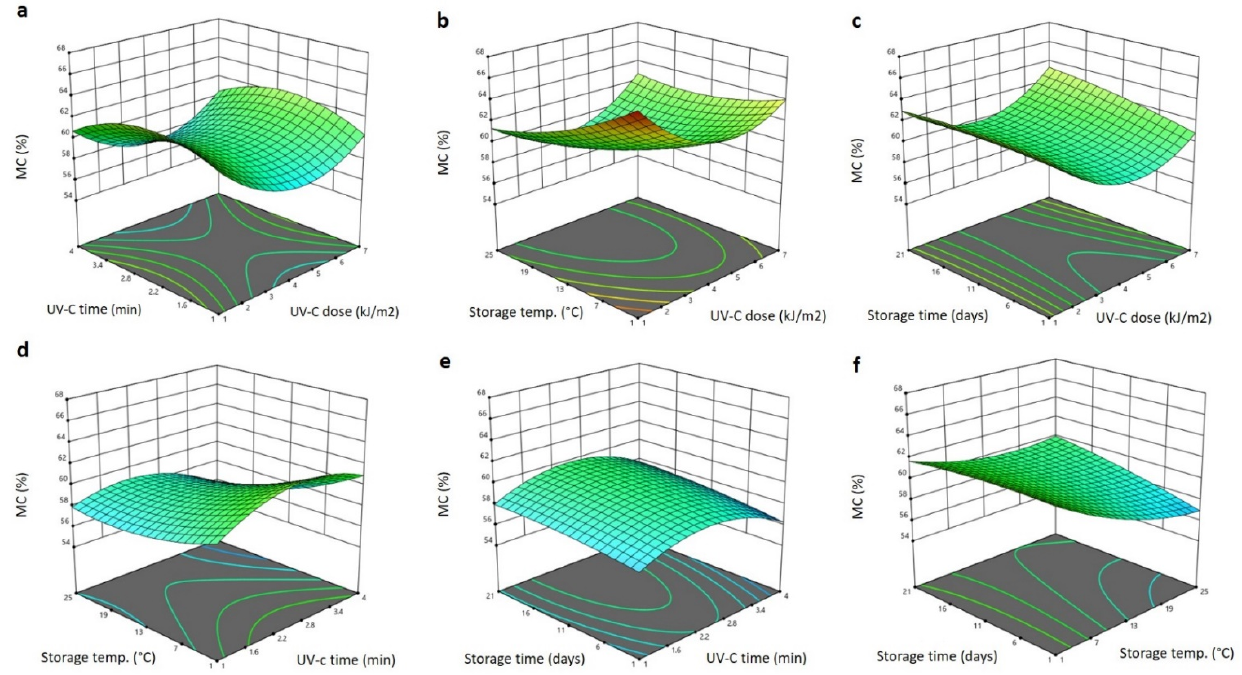
Figure 2. Response surface plots of moisture content (MC) of Barhi dates as a function of UV-C time and UV-C dose ( a ), storage temperature and UV-C dose ( b ), storage time and UV-C dose ( c ), storage temperature and UV-C time ( d ), storage time and UV-C time ( e ), and storage time and storage temperature ( f ).